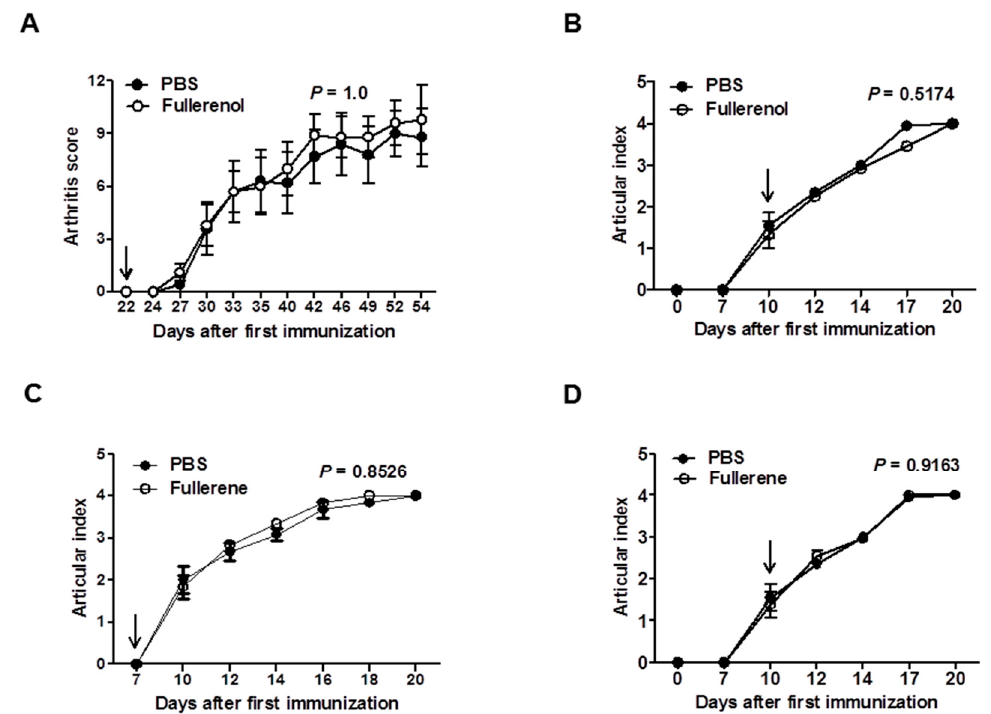
Figure 7. Arthritis scores after systemic administration, and articular indices of the therapeutic protocol and raw fullerene injection. ( A ) Mice with CIA that received the intraperitoneal (i.p.) injection of fullerenol or PBS. ( B ) Joints of rats with CIA after the i.a. injection of fullerenol or PBS using the therapeutic protocol. ( C ) Joints of rats with CIA after unmodified i.a. injection of fullerene or PBS using the prophylactic protocol. ( D ) Joints of rats with CIA after the i.a. injection of raw fullerene or PBS using the therapeutic protocol. The values of mean ± standard error are 10 mice per group in (A) and 16 joints per group in (B), (C), and (D).